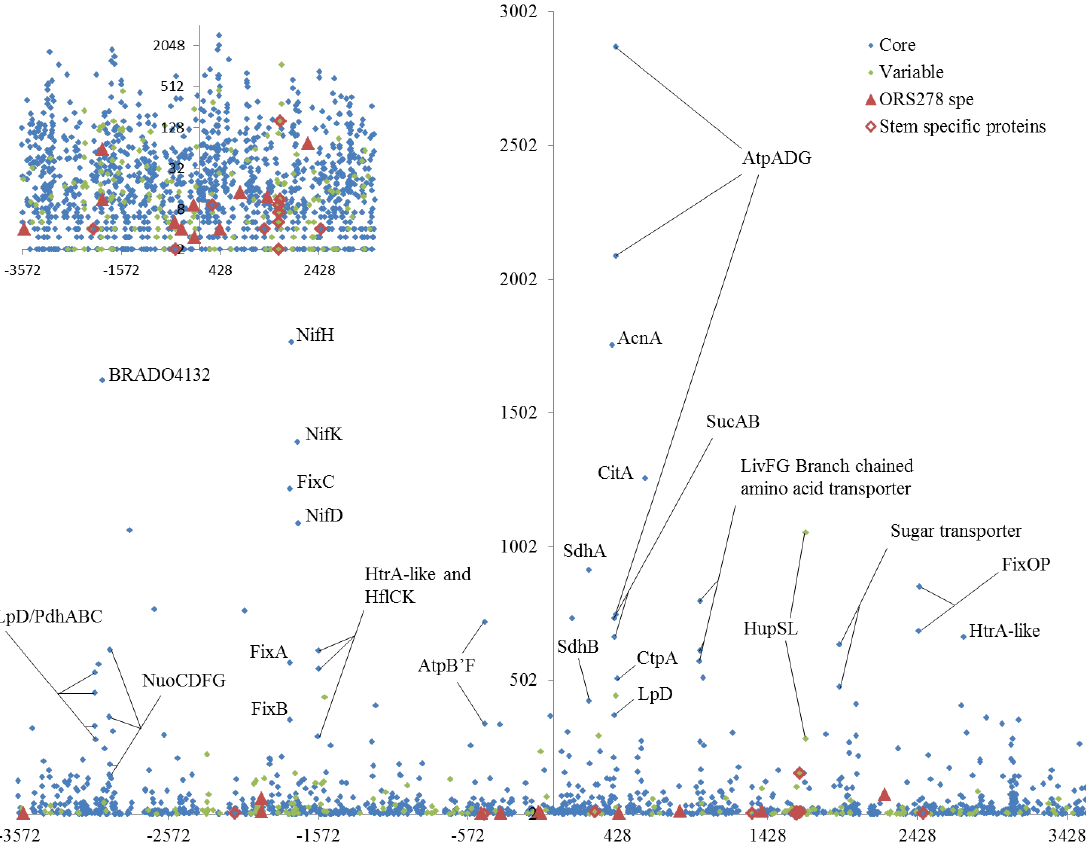
Figure 3. Symbiotic protein distributions, proteins are represented by various markers according to the nature of their corresponding gene and their specificity to the stem bacteroidal proteome. The y -axis represents the sum of assigned spectra and x -axis the position of the corresponding gene (kbp, position zero being the replication origin). The log scale used in the inset highlights the genome co-localization of most of the stem specific